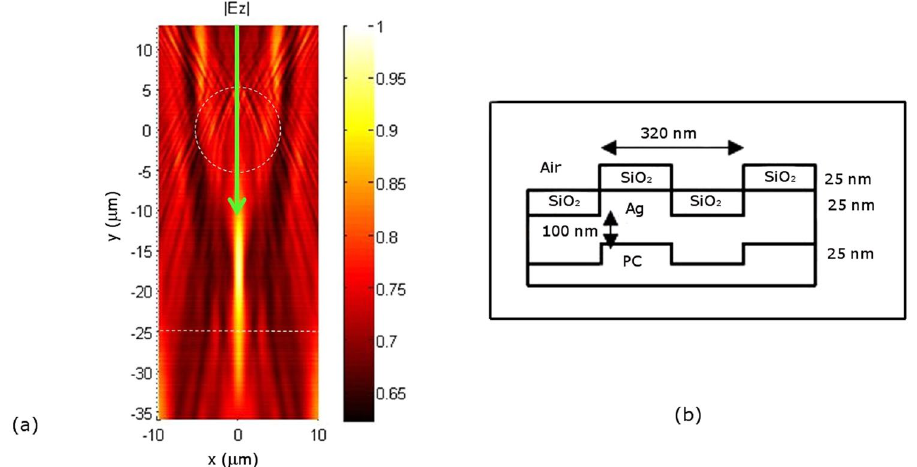
Figure 4. Simulation of instrument interaction with the Blue-ray Disc ( a ). Determining the position of the virtual image (dashed line) plane using 2D FEM simulation, absolute electric field |E z |. The first interaction (not represented) of a plane wave with the 11 µ m sphere and the Blu-ray Disc (see ( b ) for the Blu-ray Disc model) allows the calculation of the outgoing wave which is then time-reversed and propagated without the sphere. The arrow indicates the direction of light